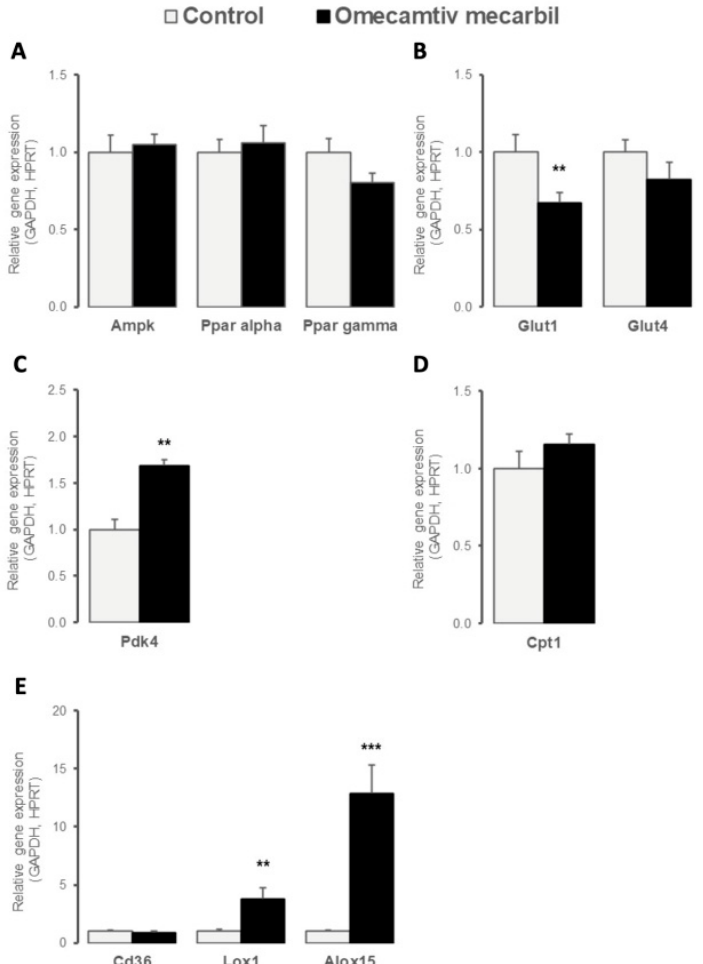
Figure 2. Myocardial left ventricular relative expression of genes implicated in cardiac metabolism, including ( A ) cellular energy sensors such as Ampk , Ppar α , and Ppar γ ; ( B ) glucose transporters Glut1 and Glut4 ; ( C ) mitochondrial metabolic regulators contributing to glucose to fatty acids shift as cardiac major energy fuel, such as Pdk4 and ( D ) Cpt1 ; and ( E ) fatty acid metabolism regulators such as Cd36 , Lox-1 , and Alox-15 , seven days after omecamtiv mecarbil (OM; n = 6; black bars) versus placebo (n = 8; grey bars) infusion. Values are presented as mean ± SD; ** 0.001 < p < 0.01, *** p < 0.001.